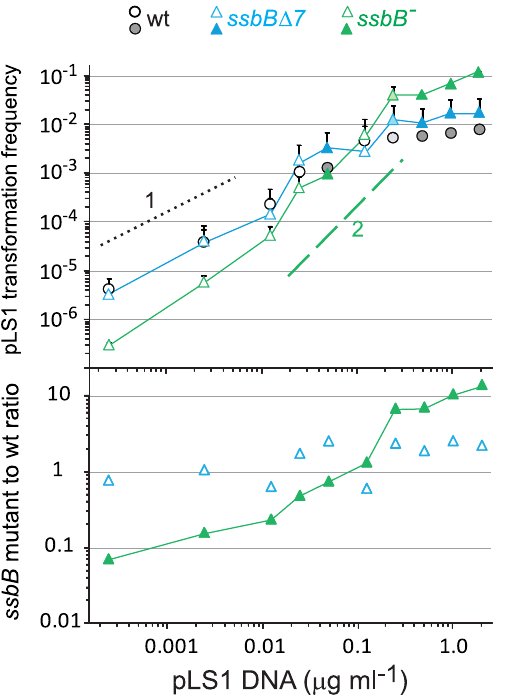
Figure 5. SsbB antagonizes plasmid transformation at high DNA concentration. Top panel: competent cells ( , 1.1 10 8 cfu ml 2 1 ) of strain R1818 ( ssbB + ), R2647 ( ssbB D 7 ) and R2646 ( ssbB 2 ) were exposed to pLS1 plasmid DNA. Tc R transformants were scored. Data are from five independent experiments with two different pLS1 DNA preparations (I and II, distinguished by open and color-filled symbols, respectively); transformation frequencies with 0.25 m g ml 2 1 DNA correspond to average of data obtained with the two preparations (light-coloured symbols). For clarity, only half error bars are figured. Dotted and dashed lines indicate, respectively, slope of 1 and 2 (i.e. linear and quadratic dependence on DNA concentration). Bottom panel: ratio of plasmid transformants between ssbB mutant and wildtype cells calculated from data in top panel.